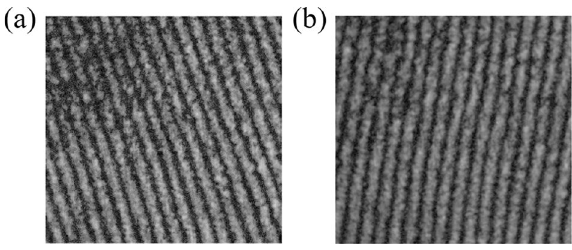
Figure 2. Output maps of different bands ( a ) S1, ( b )